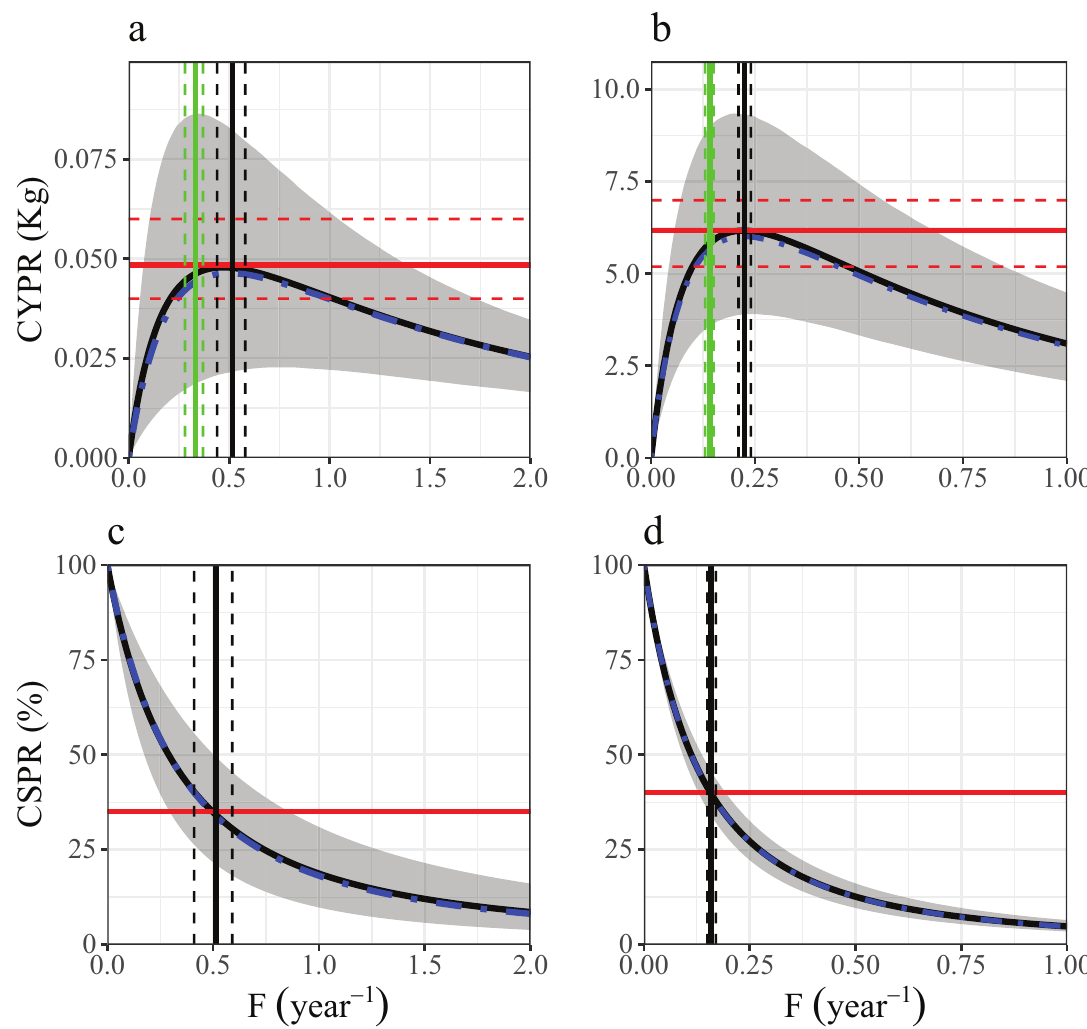
Fig. 1. Variations, against fi shing mortality ( F ), of mean (black solid line), median (blue dash-dotted line), and the 95% uncertainty envelops (gray area) of (a) and (b) the composite yield per recruit (CYPR) and (c) and (d) the composite spawning potential ratio (CSPR) based on baseline CYPR14 analyses (age of knife-edge recruitment =1 year) for L. stappersii in Lake Tanganyika (left panels) and L. niloticus in Lake Victoria (right panels). The vertical, black dashed line, solid line, and dashed line represent, from left to right, the 25% percentile, mean, and 75% percentile of F CYPR and F 35%CSPR ( L. stappersii ) or F 40%CSPR ( L. niloticus ); the vertical, green dashed line, solid line, and dashed line represent, from left to right, the 25% percentile, mean, and 75% percentile of F 0.1 ; the horizontal red dashed line, solid line, and dashed line on the CYPR plots represent, from bottom to top, the 25% percentile, mean, and 75% percentile of MSY per recruit; the horizontal red and solid line on the CSPR plots locate the levels of 35%CSPR and